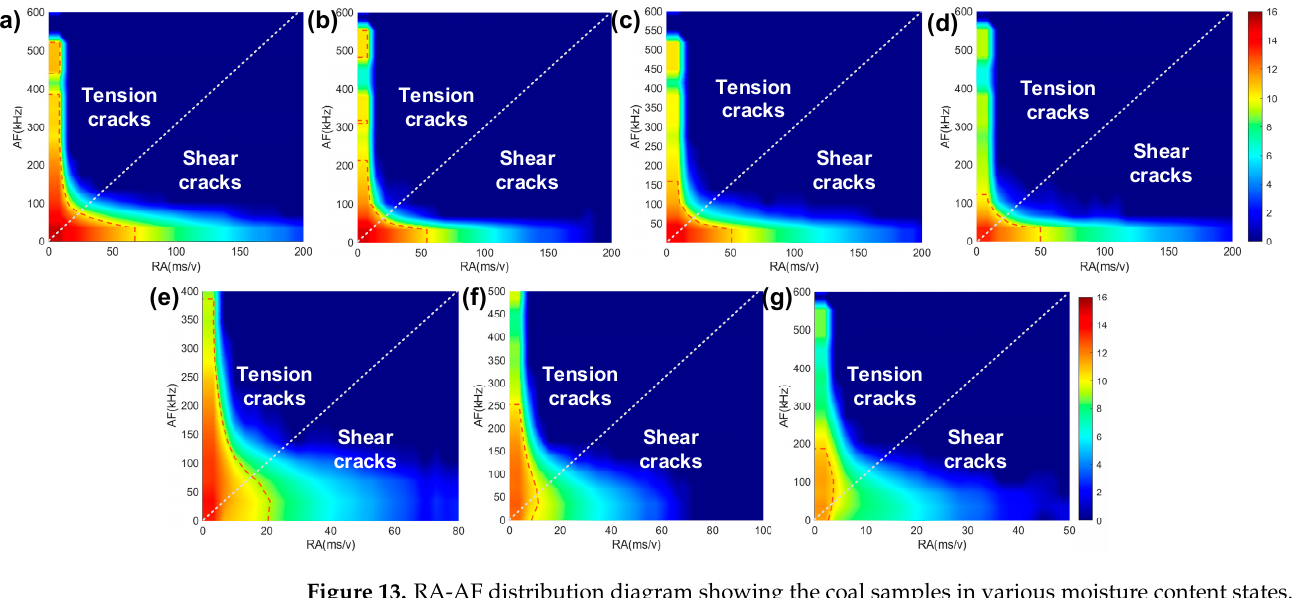
Figure 13. RA-AF distribution diagram showing the coal samples in various moisture content states. They should be listed as: ( a ) w = 0%; ( b ) w = 4.35%; ( c ) w = 8.12%; ( d ) w = 12.32%; ( e ) N = 1; ( f ) N = 2; ( g ) N = 3.